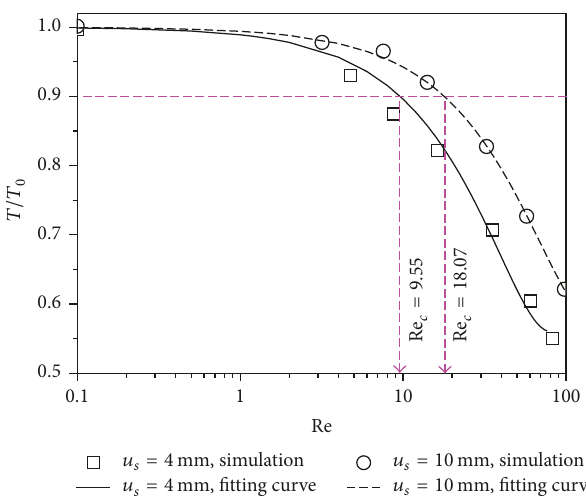
Figure 4: Relationships between T / T 0 and Re based on the data replotted from Xiong et al. ([95], Figure 12 (a)). Figure 5: Relationships between Re